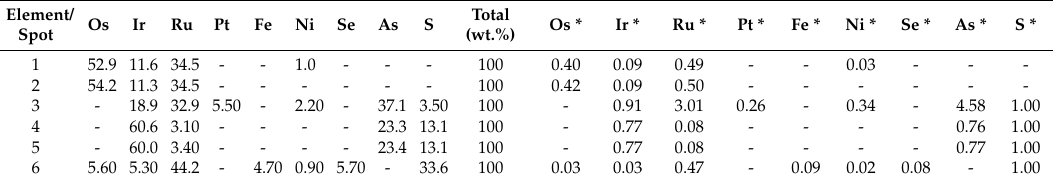
Figure 6. BSE images of base-metal minerals in chromite. ( a ) PGM of Os–Ru–Pd–S–Te; ( b , c ) heazlewoodite associated with maucherite; ( d ) heazlewoodite occurring as a single mineral phase; ( e , f ) galena occurring as a single mineral phase; ( g , h ) pentlandites associated with galena; ( i – l ) pentlandites occurring as a single mineral phase. Ni–As: maucherite; Hzl: heazlewoodite; Gn: galena; Pn:pentlandite. Table 1. Representative energy dispersive spectrometry (EDS) analyses of platinum-group minerals from the Xiadong Alaskan-type complex.